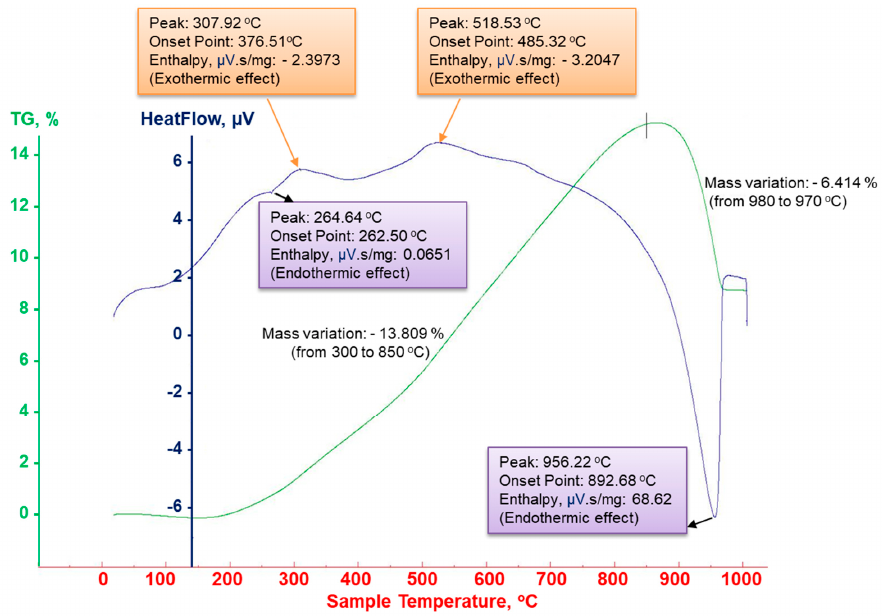
Figure 17. DSC-TG thermogram of Cu-Fe 3 O 4 nanocomposite.